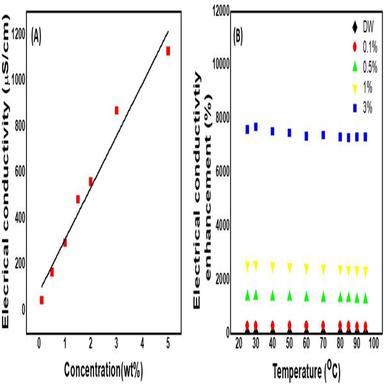
Electrical conductivity (E) and conductivity enhancement (F) of the CNC aqueous solution.